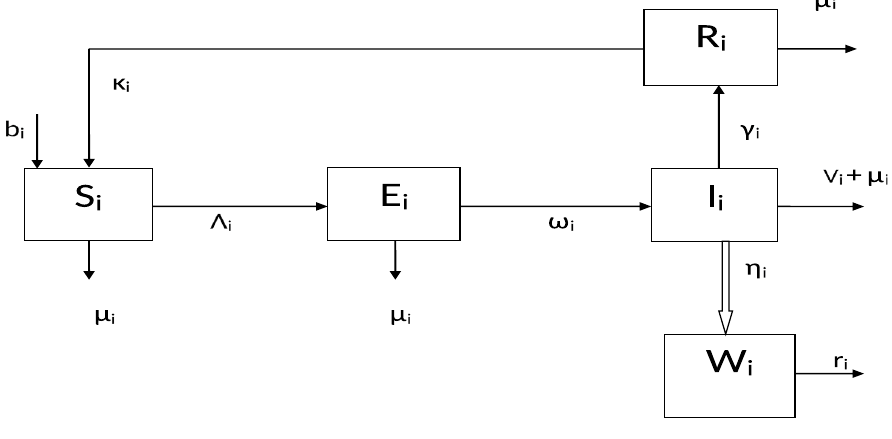
Figure 1. Model flow